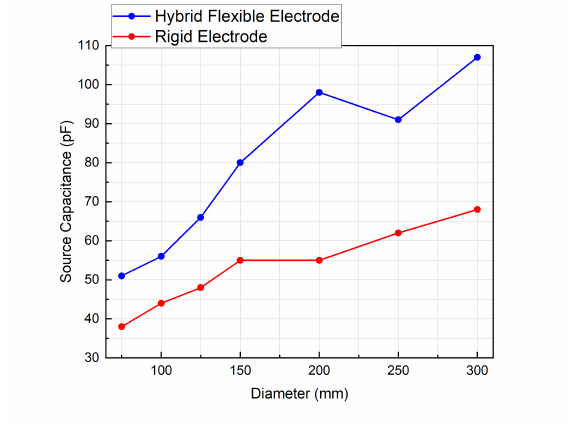
Figure 8. Capacitance vs. body diameter for hybrid flexible vs. rigid